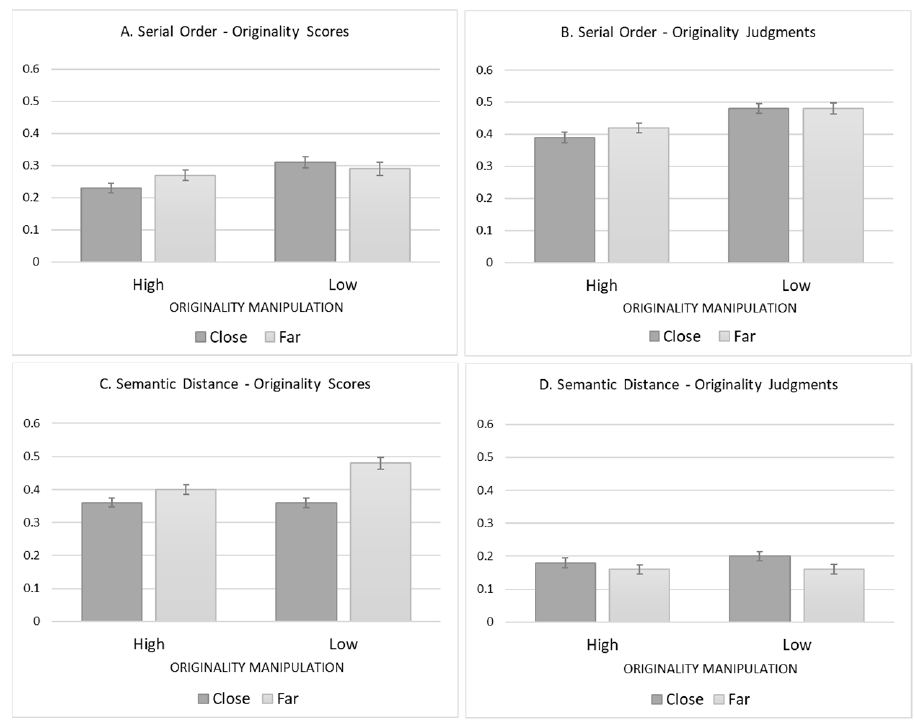
Figure 2. β of originality scores and originality judgments in the four experimental groups by the two cues that generated biases, the serial order, and the semantic distance. Error bars represent the standard error of the means for the β ’s.